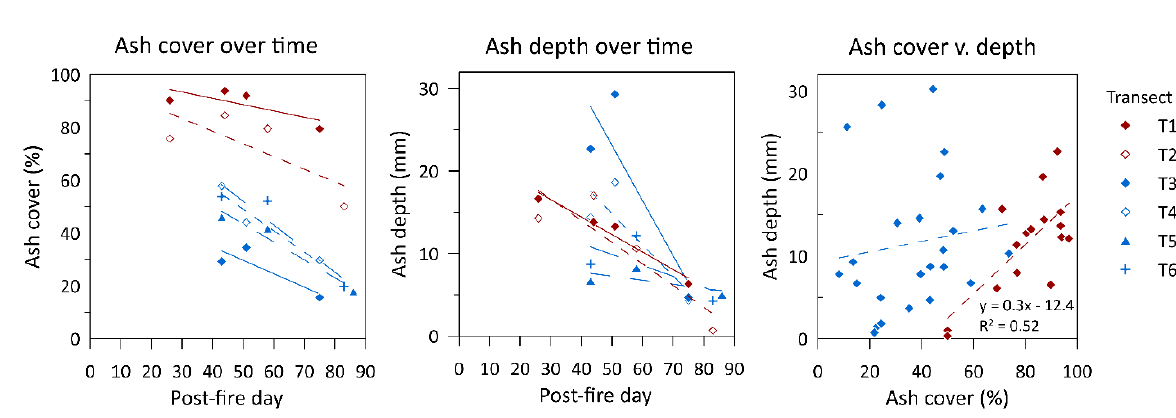
Figure 5. Mesa Fire ash cover and depth over time by transect. Transects T1 and T2 had the highest burn severity, while T3–T6 had mixed low and moderate burn severity. The right panel is color-coded by high (red) and low-moderate (blue) with all transects pooled together. Regression lines are shown to highlight trends.